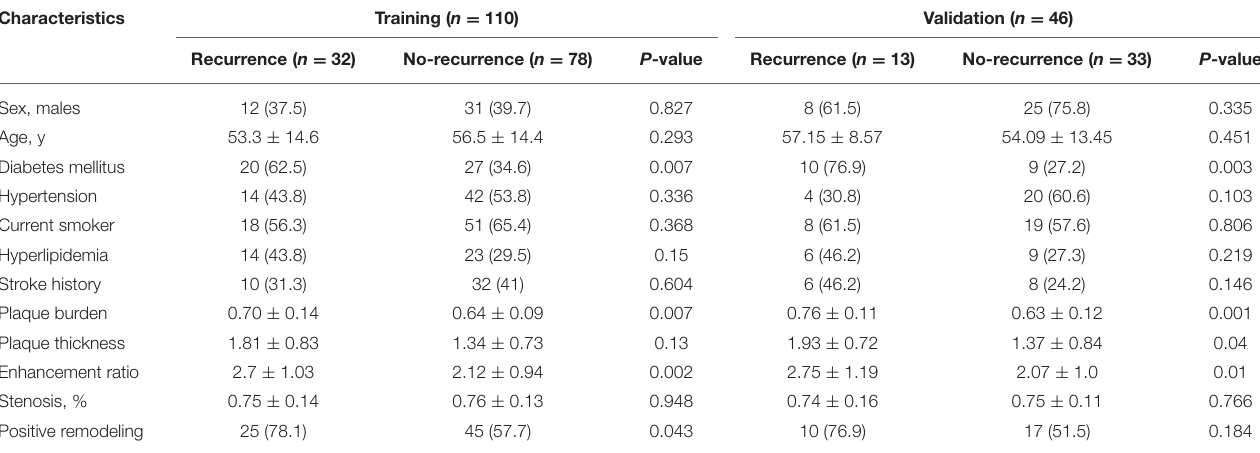
TABLE 1 | Clinical and radiological features of the SICAS in the training and validation cohort.